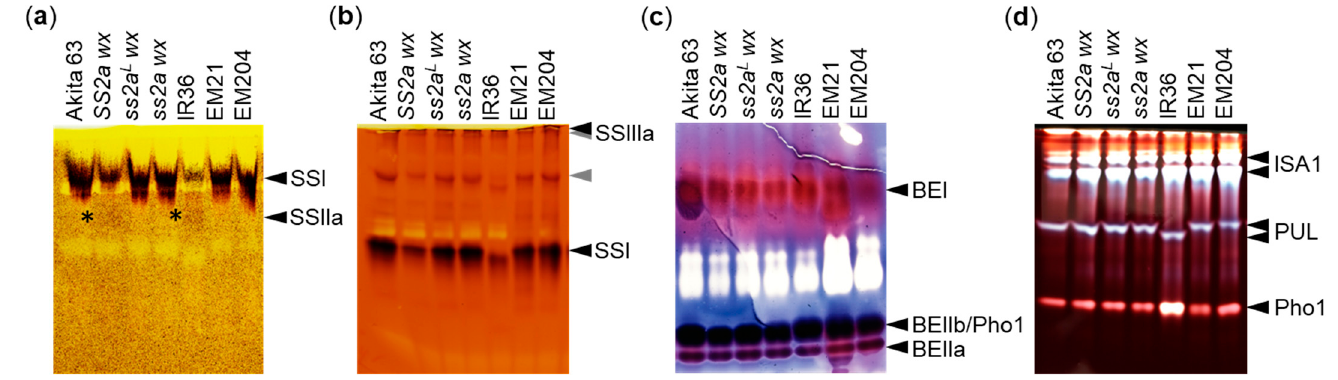
Figure 3. Activities of SSIIa and other starch biosynthetic enzymes visualized by zymogram analysis. ( a ) SSIIa activity (indicated by asterisks) visualized by polyacrylamide gel electrophoresis (PAGE) using a native gel containing maize amylopectin as a primer in the presence of ADP-glucose. ( b ) SSI and SSIIIa activities visualized by PAGE using a native gel containing oyster glycogen as a primer in the presence of ADP-glucose. Gray arrowheads likely represent the transferase or hydrolase activity of enzymes, as they also appeared in the absence of the substrate (Figure S1b). ( c ) Branching enzyme (BE) I, BEIIa, and BEIIb activities visualized by phosphorylase stimulation assay. ( d ) Activities of debranching enzymes (DBEs; ISA1 and PUL) and Pho1 visualized by PAGE using a native gel containing potato amylopectin. All gels were stained with iodine after the reaction.